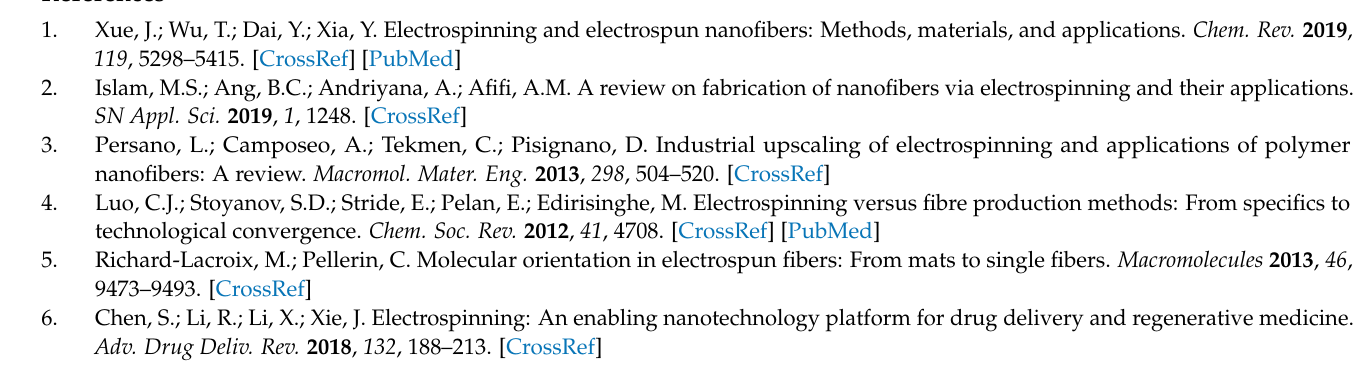
periment 2; Figure S2: Fibers obtained in experiment 2 before and after heat treatment. (Optical microscopy and FTIR); Figure S3: Pictures of fibers obtained in experiment 3; Figure S4: Fibers obtained in experiment 3 before and after heat treatment. (Optical microscopy and FTIR); Figure S5: Pictures of fibers obtained in experiment 4; Figure S6: Fibers obtained in experiment 4 before and after heat treatment. (Optical microscopy and FTIR); Figure S7: TGA analysis of the fibers prepared in experiment 5; Figure S8: Pictures of fibers obtained in experiment 7; Figure S9: Fibers obtained in experiment 7 before and after heat treatment. (Optical microscopy and FTIR); Figure S10: Zoom of the FTIR spectra of (from top to bottom): fibers from experiment 7, fibers from experiment 7 heated Table S1: solubility of the fiber, Video S1: electrospinning of polymer 1, IPDA, and a purple dye at 1